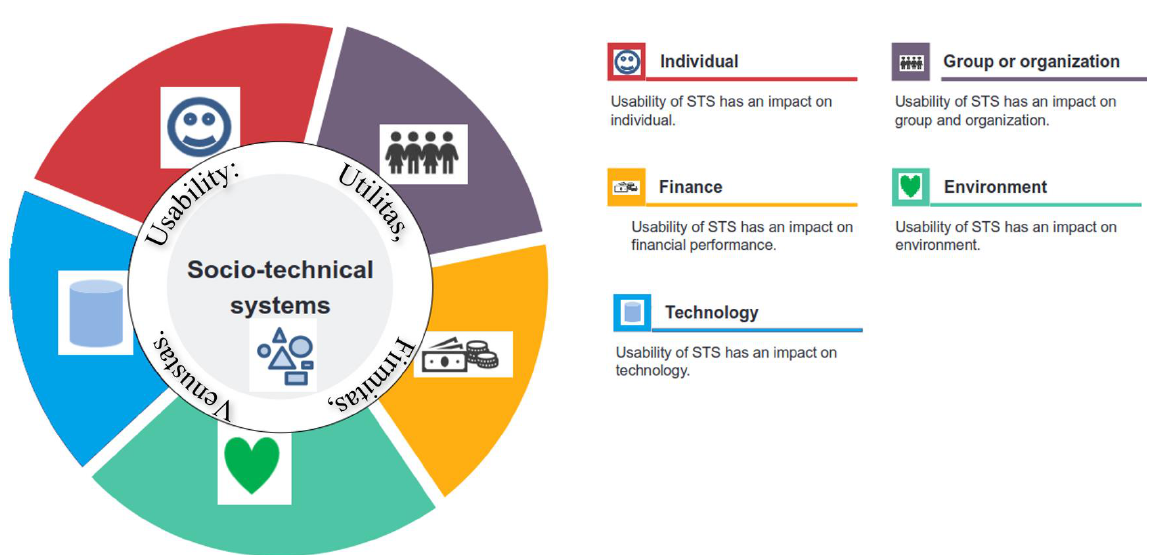
Figure 1. Usability as speculum mundi. Socio-technical systems (shown in the center of the diagram) influence an organization and society at large at different levels through usability: individual, group, financial, environmental and